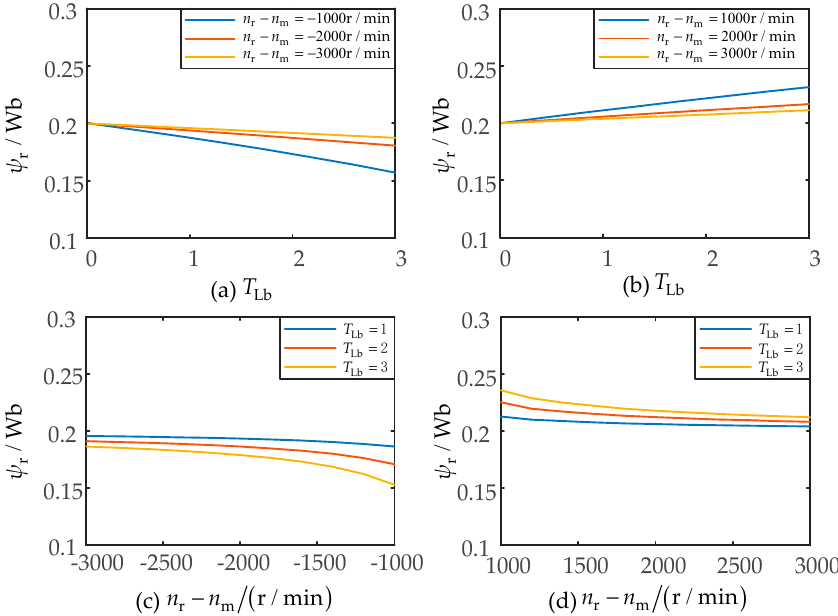
Figure 8. The reference value of rotor flux. ( a ) The relationship of the rotor flux with torque when n r − n m < 0. ( b ) The relationship of the rotor flux with torque when n r − n m > 0. ( c ) The relationship of the rotor flux with speed difference when n r − n m < 0. ( d ) The relationship of the rotor flux with speed difference when n r − n m > 0.